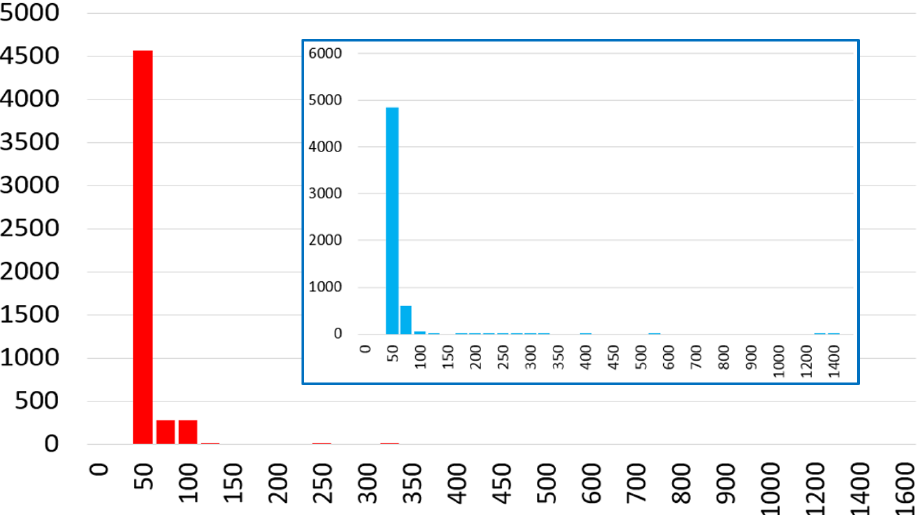
Figure 12. Downlink (red) and uplink (blue) traffic packet size distribution of APN “A2” (x axis: number of packets, y axis: Size of flows